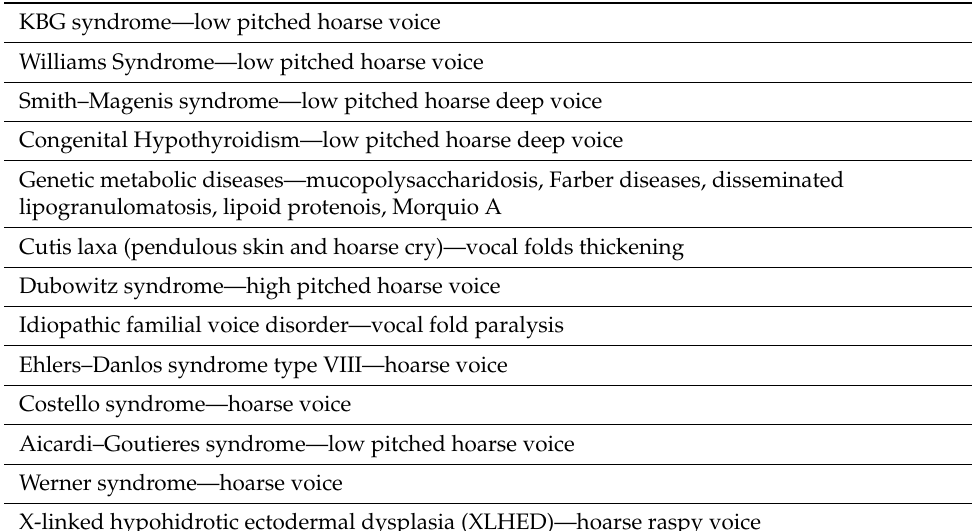
Table 5. Differential diagnosis of voice disturbances in genetic